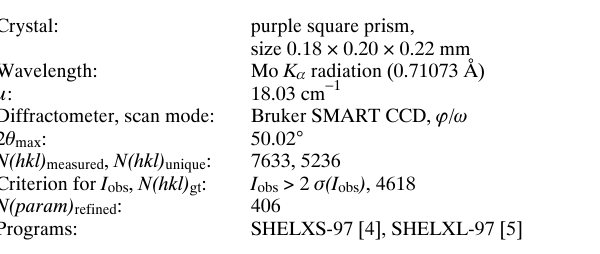
Table 1. D a t a collection a nd h a ndling.